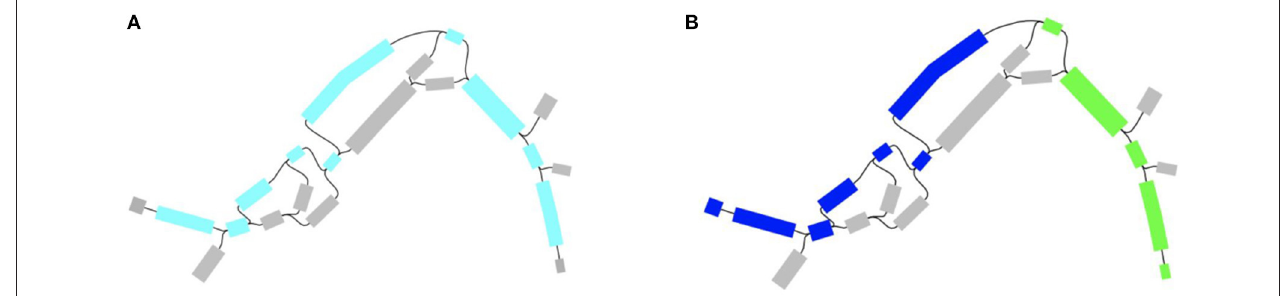
FIGURE 2 | bla IMP sequence in the assembly graph. (A) Gene sequence scattered over 10 edges, (B) Gene sequence is splitted across two scaffolds.